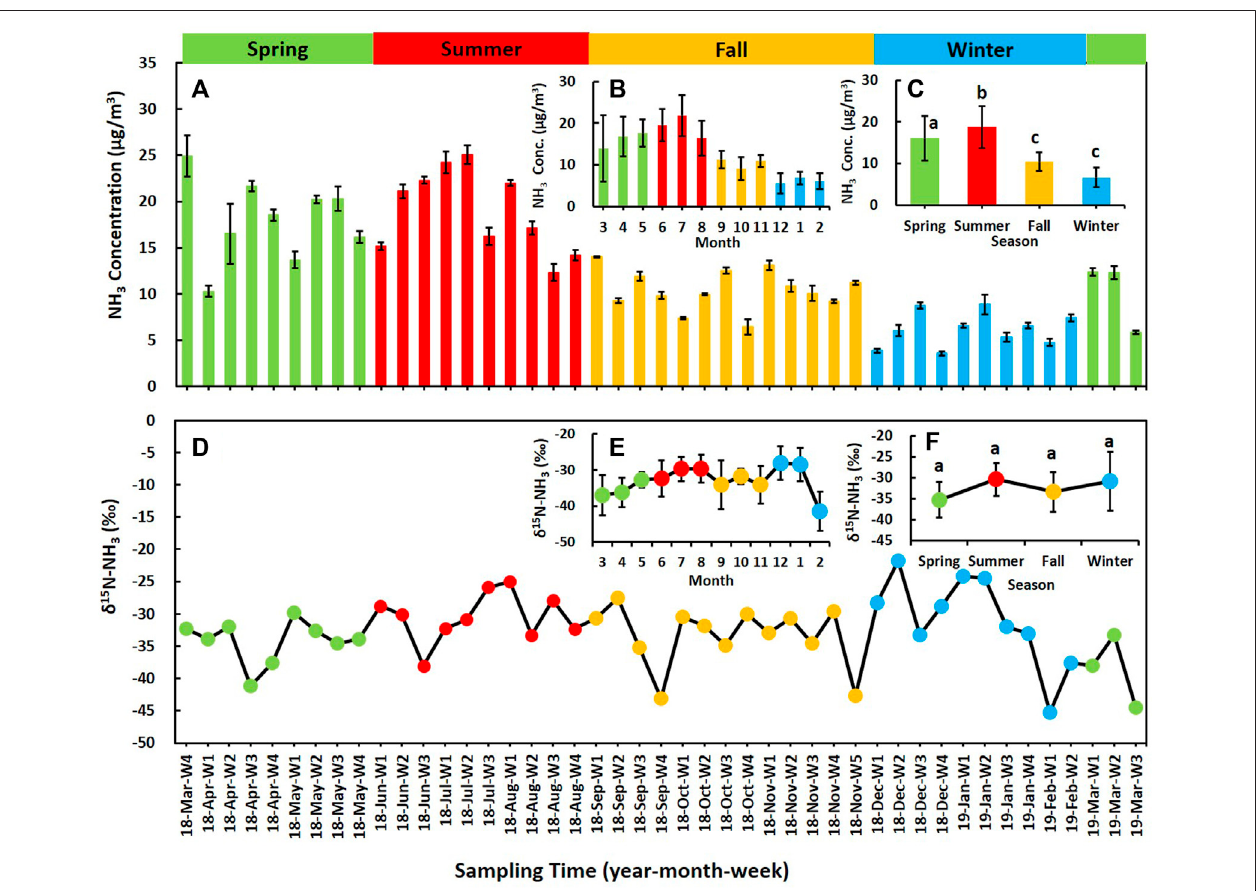
FIGURE 4 | Time series of ambient NH 3 concentration and δ 15 N values. (A) shows the concentration of weekly NH 3 samples. (B) shows the monthly average NH 3 concentration. (C) shows the average concentration of NH 3 in four seasons. (D) shows δ 15 N value and concentration of weekly NH 3 samples. (E) shows the monthly average of δ 15 N-NH 3 value. (F) shows the average δ 15 N-NH 3 value in four seasons. Different letters on the top of the error bars on (C) and (F) indicate signi fi cant difference in mean NH 3 concentration and insigni fi cant difference in mean δ 15 N values among four seasons ( p <